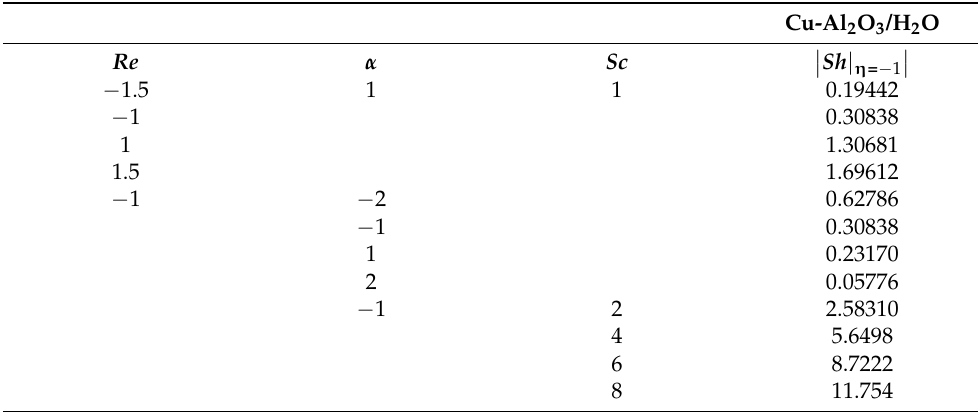
Table 5. Different parameter Re (Reynold number), α (wall expansion parameter) Sc (Schmidt number) effects on Sherwood